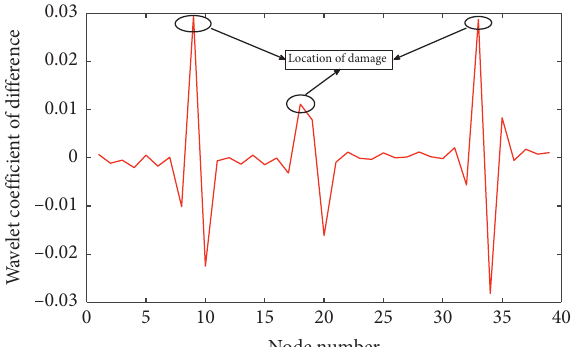
Figure 9: Wavelet coefficient difference for 6% damage in sections 9, 19, and 34.